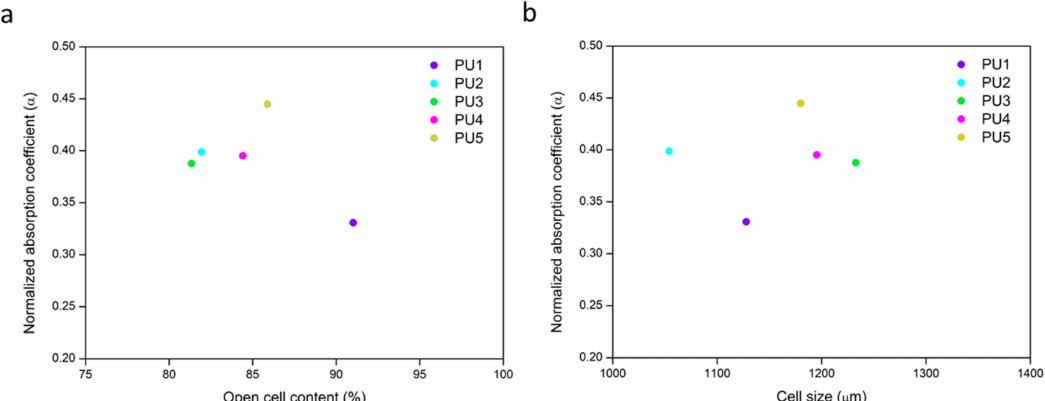
Figure 6. Relationship between the normalized absorption coefficient ( α ) between 500 and 6500 Hz and the open cell content ( a ); cell size ( b ) for all the